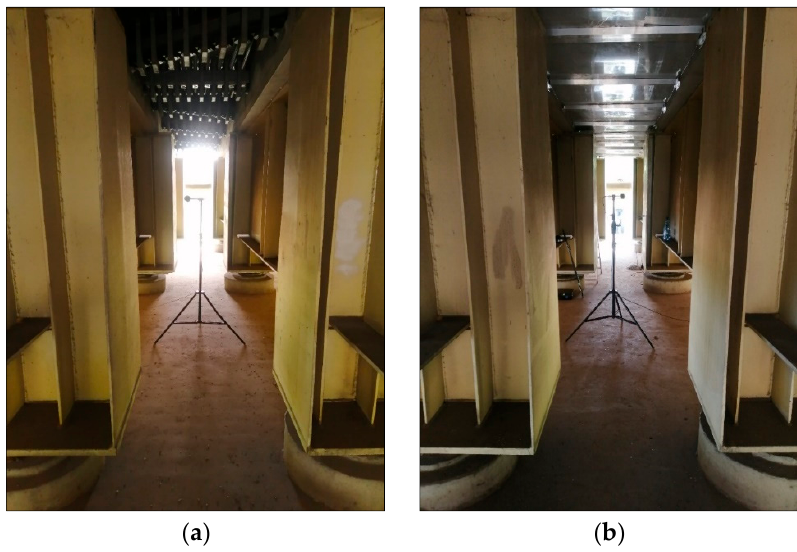
Figure 2. The location of: ( a ) the measurement microphone under the expansion joint device without the cover used (the reference expansion joint); ( b ) the measurement microphone under the expansion joint device with the cover used (the tested dilatation).